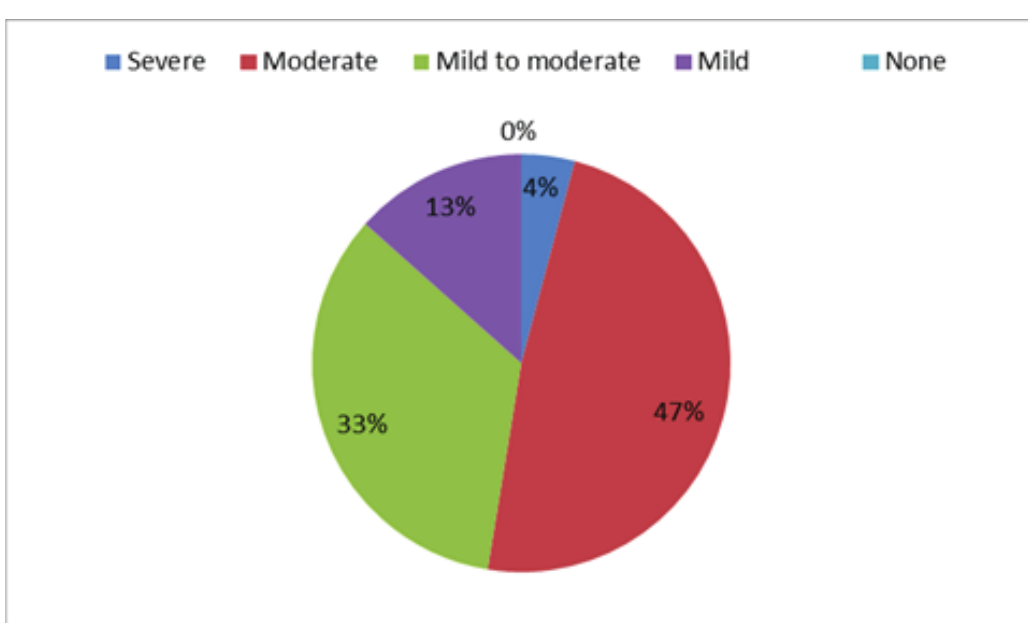
Figure 6: The severity of sexual desire impairment among the studied group.